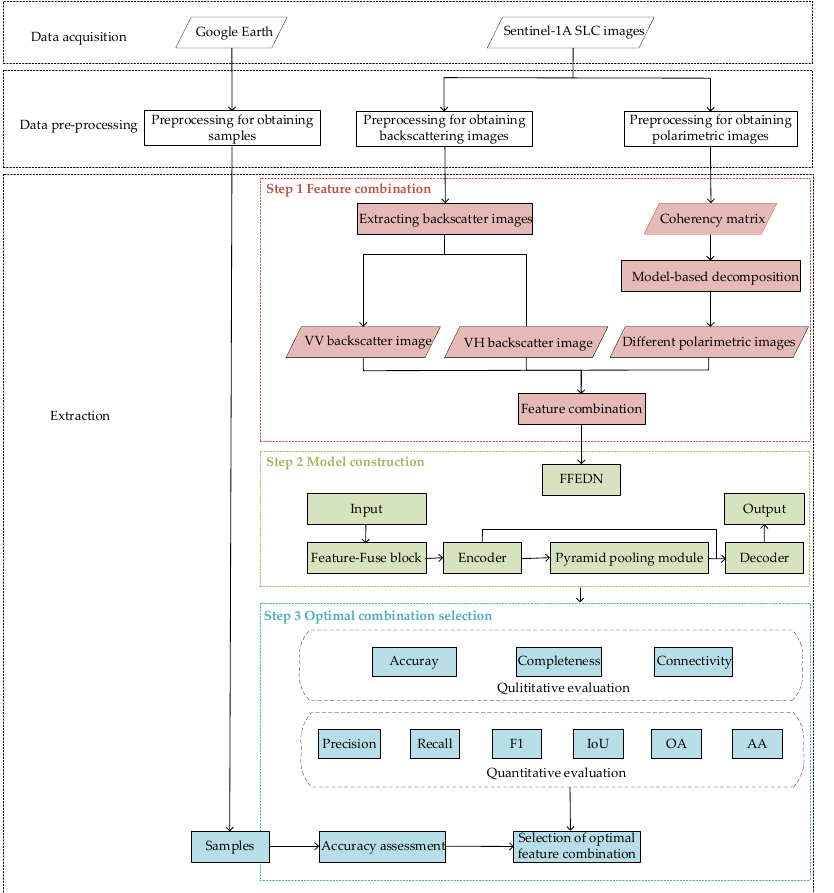
Figure 4. Flow chart of the proposed method.